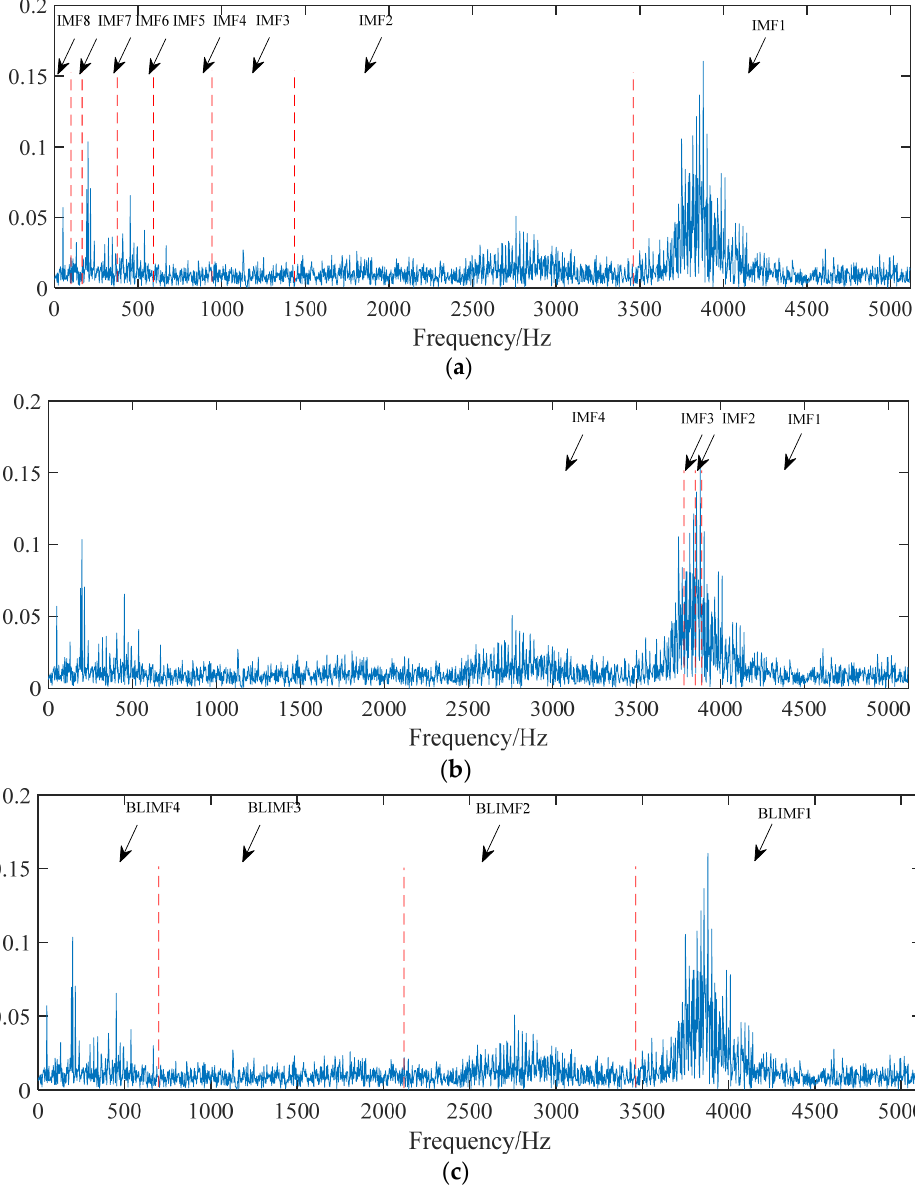
Figure 7. The spectrum segmentation boundaries: ( a ) The boundary of CEEMDAN; ( b ) The boundary of EWT; ( c ) The boundary of VMD. The X and Y labels of all plots are “Frequency(/Hz)” and “Amplitude (/V)”, respectively. The same caption rule applies to all frequency domain plots hereinafter.